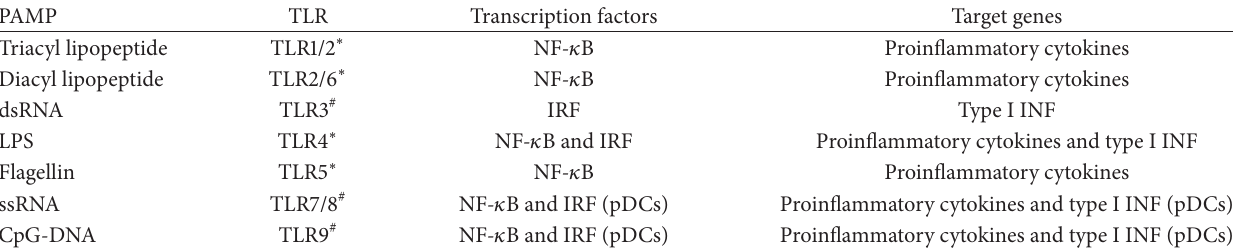
Table 1: Recognition and signaling by Toll-like